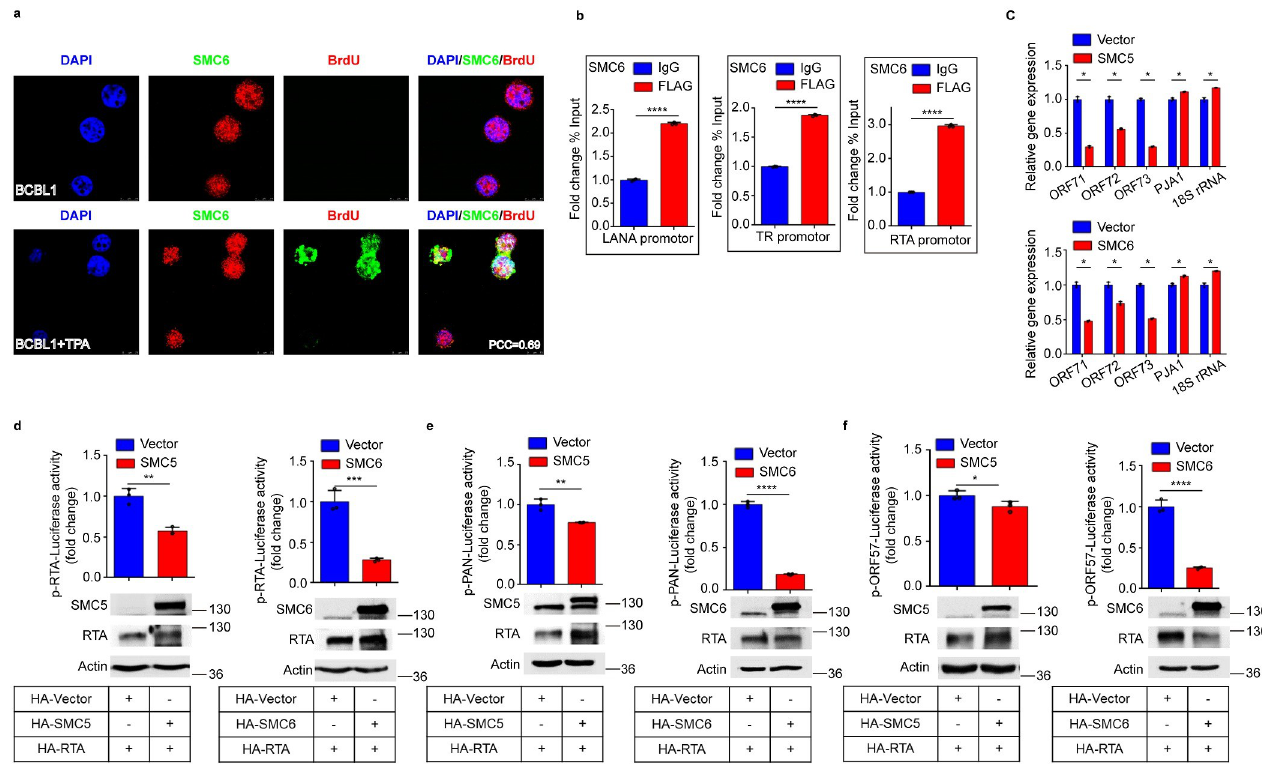
Fig 3. The SMC5/6 complex associates with the KSHV genome and suppresses KSHV gene transcription. (a) The SMC5/6 complex colocalizes with KSHV genomic DNA. BCBL1 cells were treated with TPA (20ng/ml) for 24h followed by incubating with BrdU for 2h, then immunofluorescence was performed to observe the colocalization of endogenous SMC6 and KSHV genomic DNA. Colocalization analysis was performed using Image J software. (b) SMC6 binds to the KSHV genome. ChIP experiments were performed in latently infected SMC6-overexpressing cells using anti-FLAG antibody and the episomal DNA of KSHV was measured by qPCR. Data was calculated as the fold change in percentage of input DNA compared with control ChIP experiment. (c) Effect of SMC5 and SMC6 on KSHV latent genes transcription (ORF71, ORF72 and ORF73). Total RNA extracted from latently infected SMC5- and SMC6-overexpressing cells was evaluated via qPCR. (d-f) Effect of SMC5 and SMC6 on RTA-mediated RTA, PAN and ORF57 promoter activation. HEK293T cells were transfected with 200ng RTA/PAN/ORF57-promoter and other plasmid DNA as indicated. 36h post-transfection, cells were lysed and luciferase activities were analyzed. Lysates of cells were also subjected to western blot analysis. Representative results from three biological replicates are presented. Error bars indicate SD. Data were analyzed with Student’s t tests ( � p < 0.05, �� p < 0.01, ��� p < 0.001, ���� p <